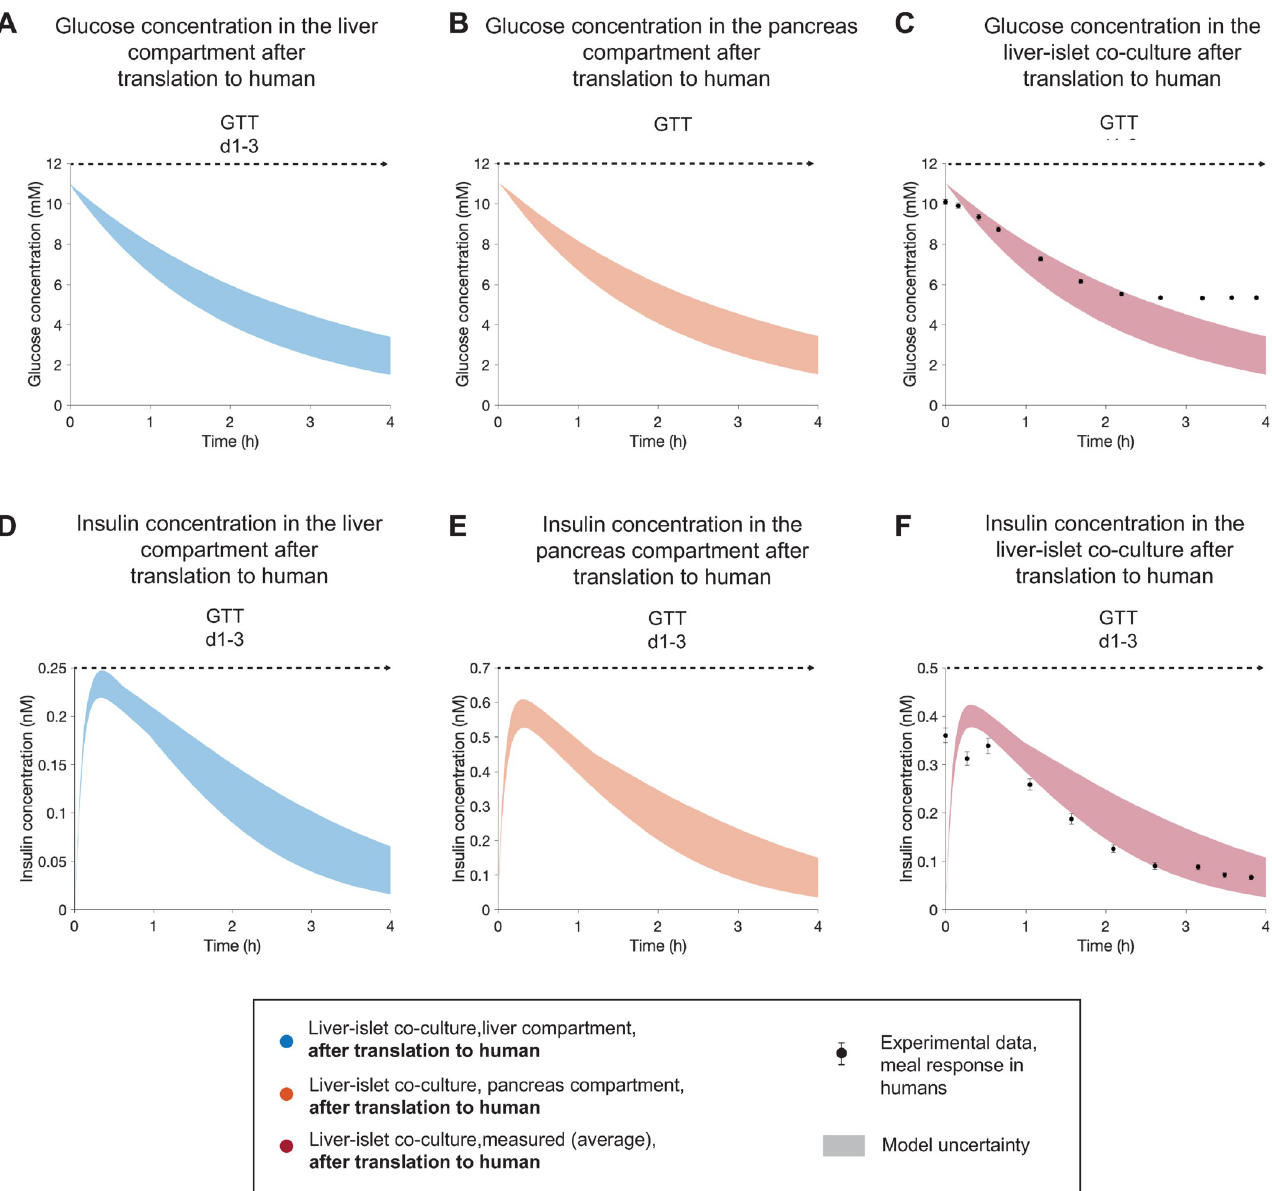
Fig 8. Model-based extrapolation of glucose and insulin concentrations in the HepaRG liver-islet MPS to human meal responses. The results correspond to a single experiment (experiment 1). A,B,D,E Model predictions of glucose (A,B) and insulin (D,E) in the liver and islets compartments after scaling to human. C shows the comparison between the model prediction of plasma glucose concentration in a corresponding human and experimental data of glucose response to a meal in healthy subjects [66]. The model-based prediction of the insulin response and the experimental measurements of insulin are compared in F . The predictions are computed for the GTT initiated at day 1 (GTT d1-3). The experimental data, reported in a previous study by Dalla Man et al. [66], were acquired in a group of 204 normal subjects. We consider the time point of peak glucose concentration in the experimental data as time = 0 h for this study, since the HepaRG liver-islet MPS lacks an intestinal compartment and glucose is administered directly to the liver and pancreas compartments. Data are presented as mean ± SEM, n = 204. Model uncertainty is depicted as shaded areas in (A-F)